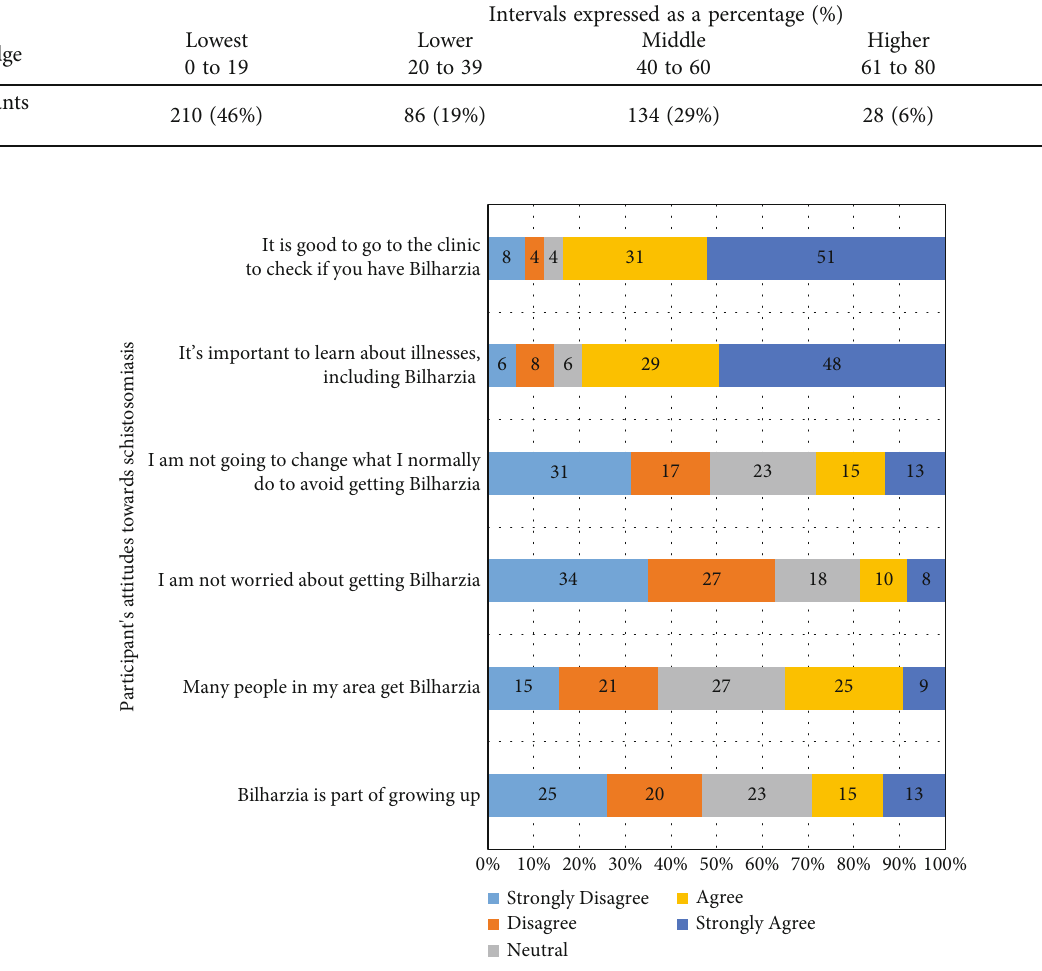
Figure 7: Study participants ’ attitudes towards